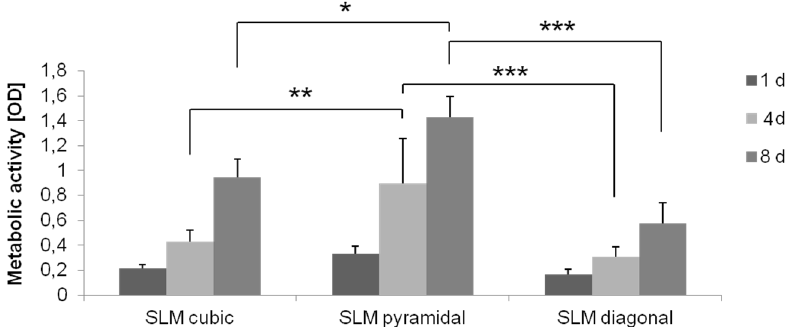
Figure 9. Metabolic activity of human osteoblasts cultured under static conditions over eight days on SLM manufactured structures with several designs (cubic, pyramidal, diagonal).